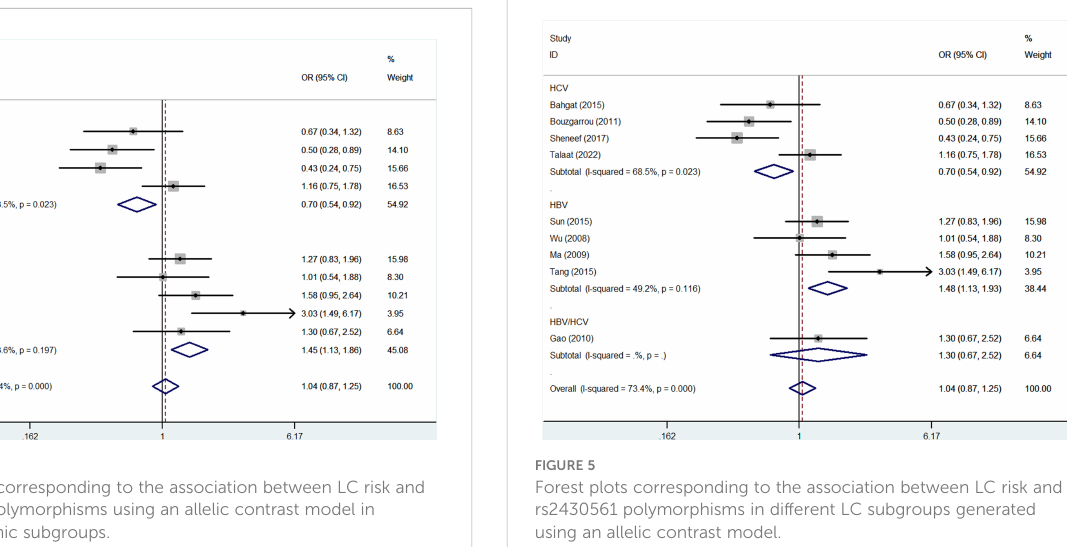
P h ,valueofQ-testforheterogeneitytest;P,Z-testforthestatisticalsigni fi canceoftheOR;HB,hospital-based;PB,population-based;SOC,sourceofcontrol;PBC,primarybiliarycirrhosis;ALC, alcoholic liver cirrhosis; HBV, hepatitis B virus; HCV, hepatitis C virus. The bold values stand for the signi fi cant relationships.